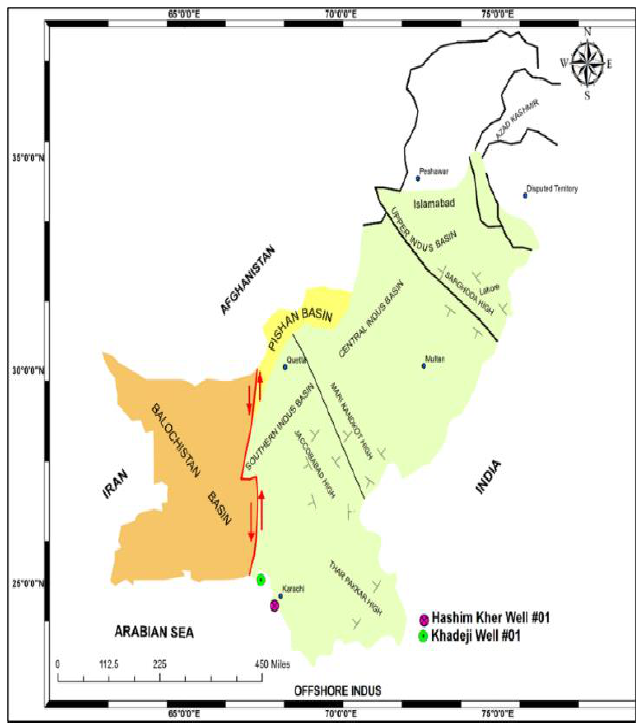
Figure 1: Map showing sedimentary Basins of Pakistan (Farah et al., 1984). The research area is represented by Hashim Kher and Khadeji wells.